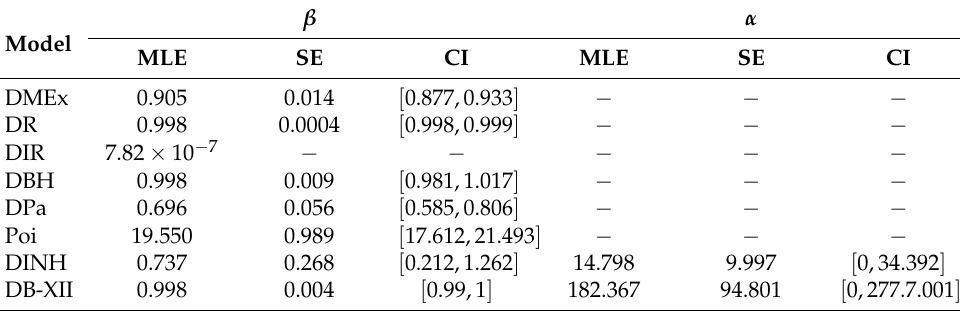
Table 10. The MLE, SE, and CI for LR